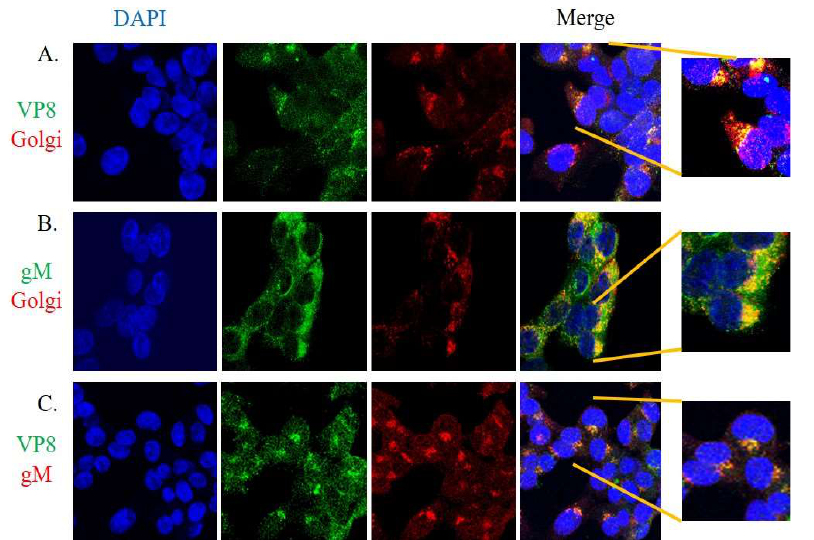
Figure 5. Co-localization of VP8 and gM at the Golgi in cells infected with WT BoHV-1. MDBK cells infected with WT BoHV-1 were fixed and incubated with antibodies specific for VP8, gM, or Golgi. Alexa 488-conjugated goat anti-rabbit or goat anti-mouse IgG and Alexa 633-conjugated goat anti-rabbit or goat anti-mouse IgG were used to detect the primary antibodies. ( A ) VP8 (green) and Golgi (red), and localization of VP8 in the Golgi in the merged image (yellow). ( B ) Glycoprotein M (green) and Golgi (red), and localization of gM in the Golgi in the merged image (yellow). ( C ) VP8 (green) and gM (red), and co-localization of VP8 and gM as shown in the merged image (yellow). The nuclei were stained with Prolong gold DAPI. Cells in the boxes are magnified 5X. The cells were examined with a Leica SP8 confocal microscope.